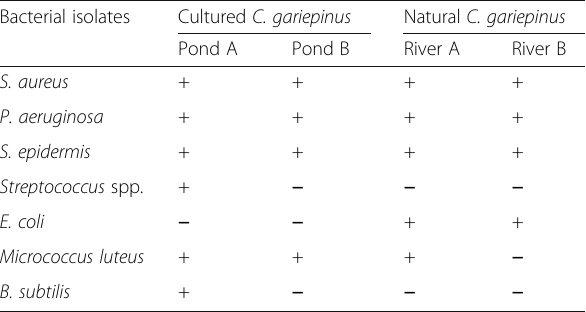
Table 3 Occurrence of bacteria isolates from C. gariepinus obtained from cultured and natural habitats Bacterial isolates Cultured C.